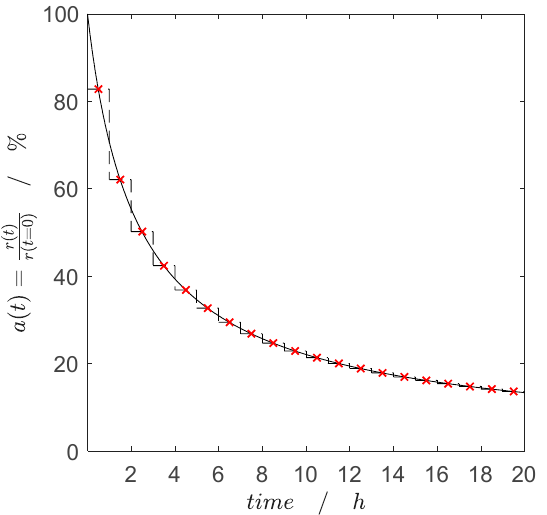
Figure 6. Activity–time relationship and discretization; x C